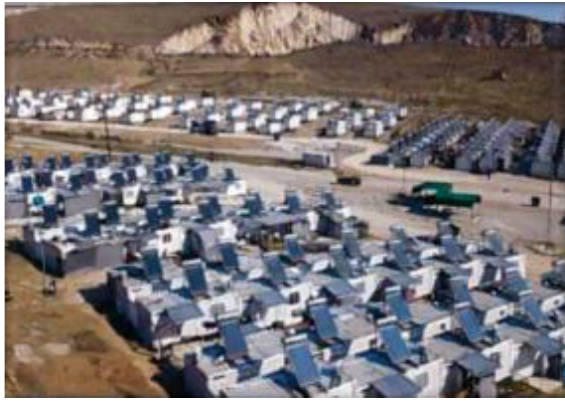
Figure 1. Koutsochero camp in Larisa, September 2020. Source: International Organization of Migration